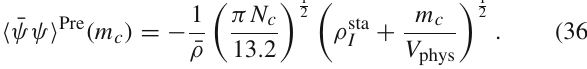
Fig. 13 Comparisons oftherenormalizedchiralcondensate (cid:5) ¯ ψψ (cid:6) MS in the MS-scheme at 2 [GeV] of the configurations of β = 6 . 0000, V = 14 3 × 28 and V = 16 3 × 32 (left) and the interpolated results at the continuum limit (right) with the predictions (cid:5) ¯ ψψ (cid:6) Pre . In the left figure, the black full, the blue full, and the blue dashed